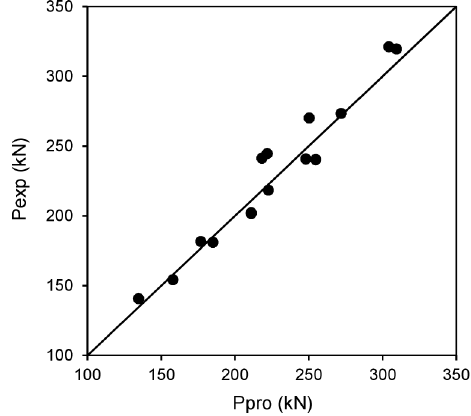
Fig. 5. Experimental and proposed load-carrying capacity of NPSTC